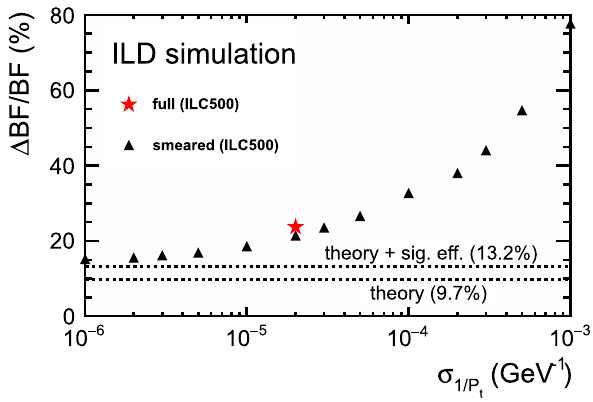
Fig. 10 Expected precision on BF ( H → μ + μ − ) as a function of transverse momentum resolution σ 1 / P simulation results discussed in Sect. 3.7 (star) and the theoretical limits defined in Sect. 3.7 (dashed lines) for 4 ab − 1 collected at